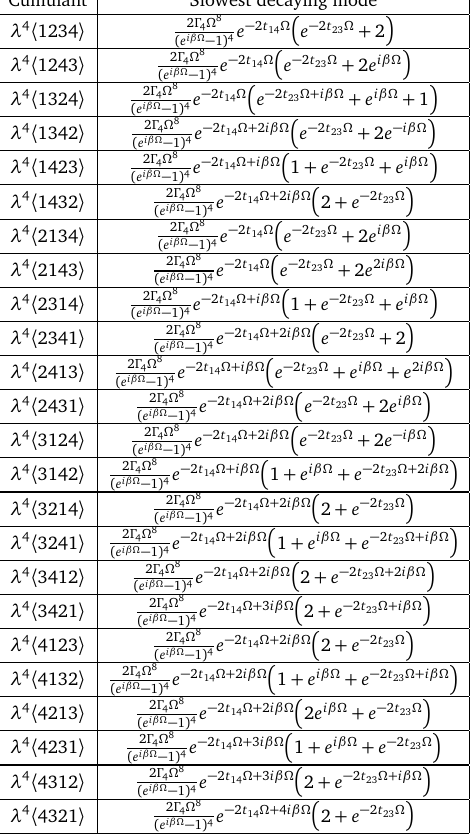
Table 5: Decay of 4-point cumulants for t